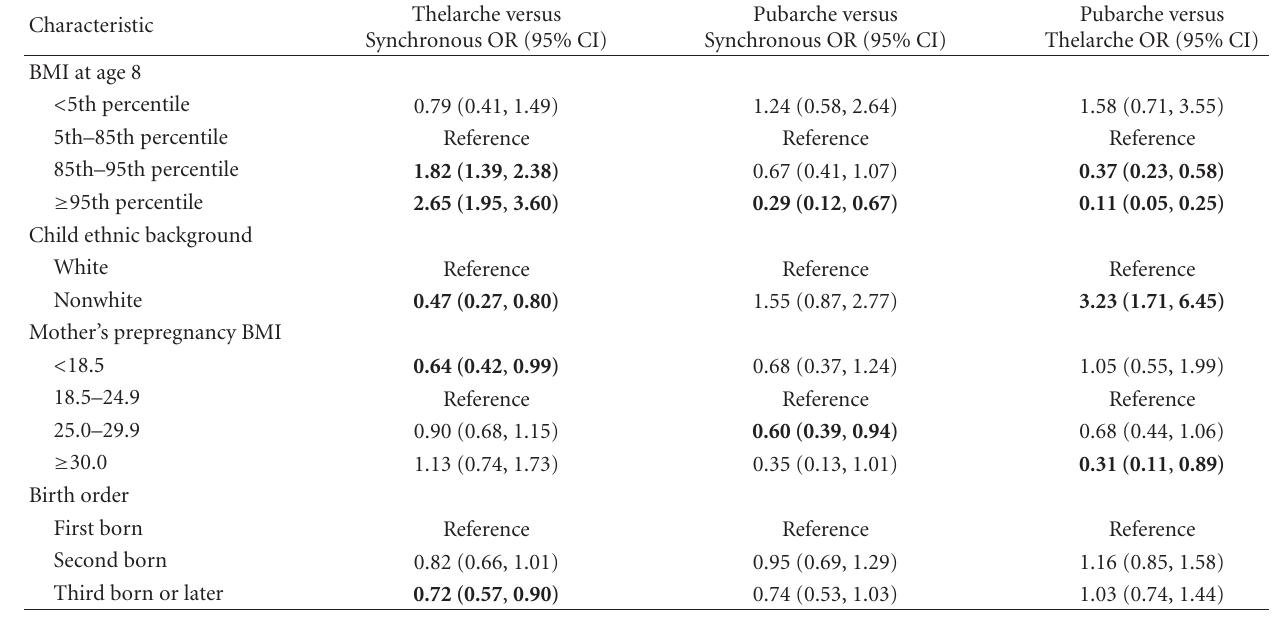
Table 3: Polytomous logistic regression model for initiation pathway.